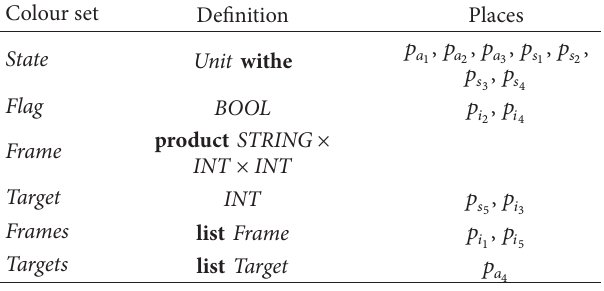
Table 1: Colour set definitions.